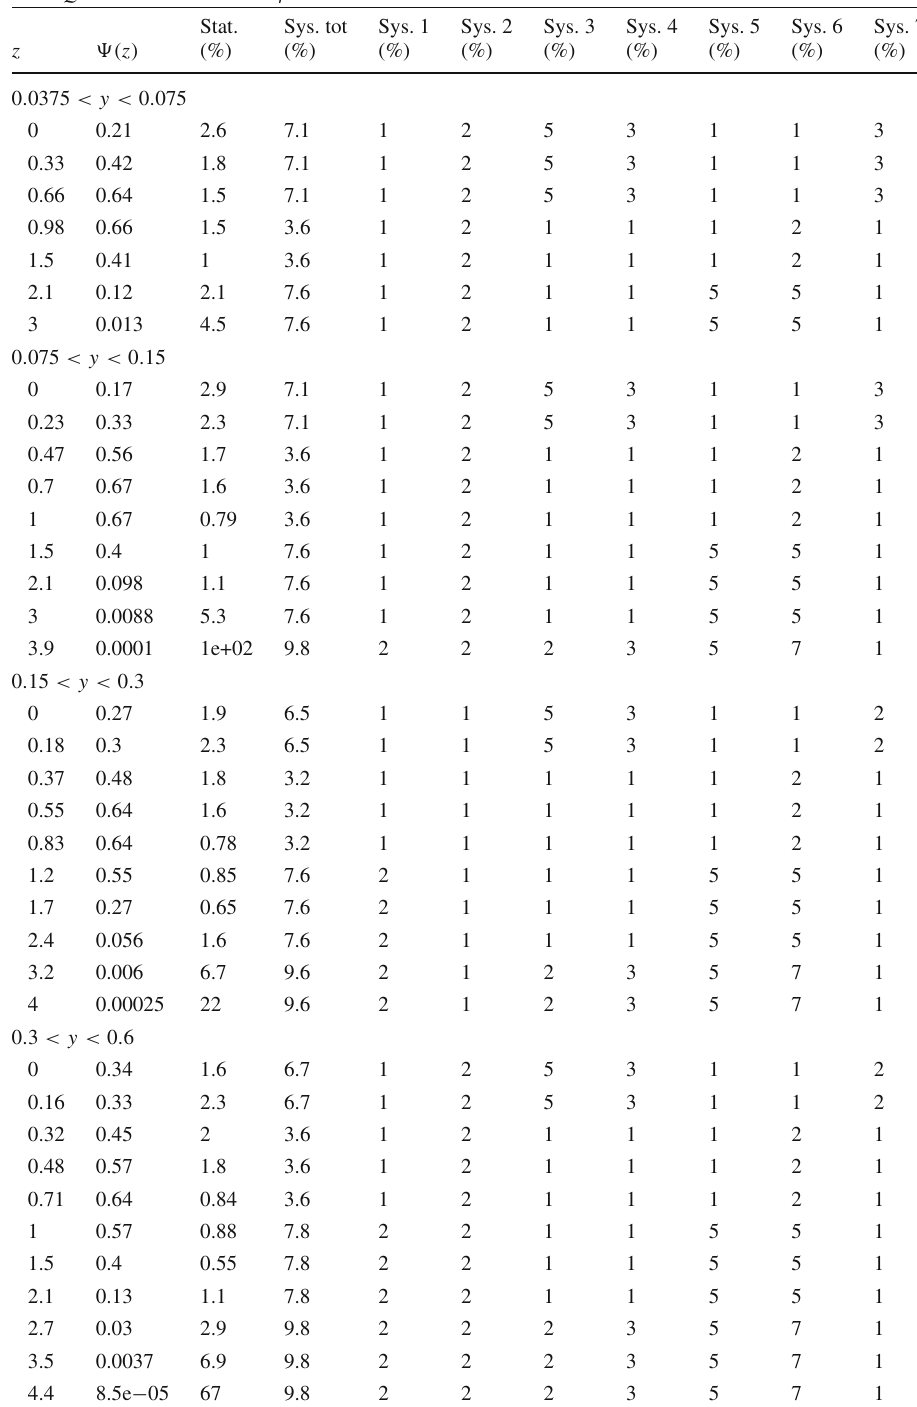
KNO function of multiplicity distributions in DIS 10 < Q 2 < 20 GeV 2 and 0 < η ∗ <